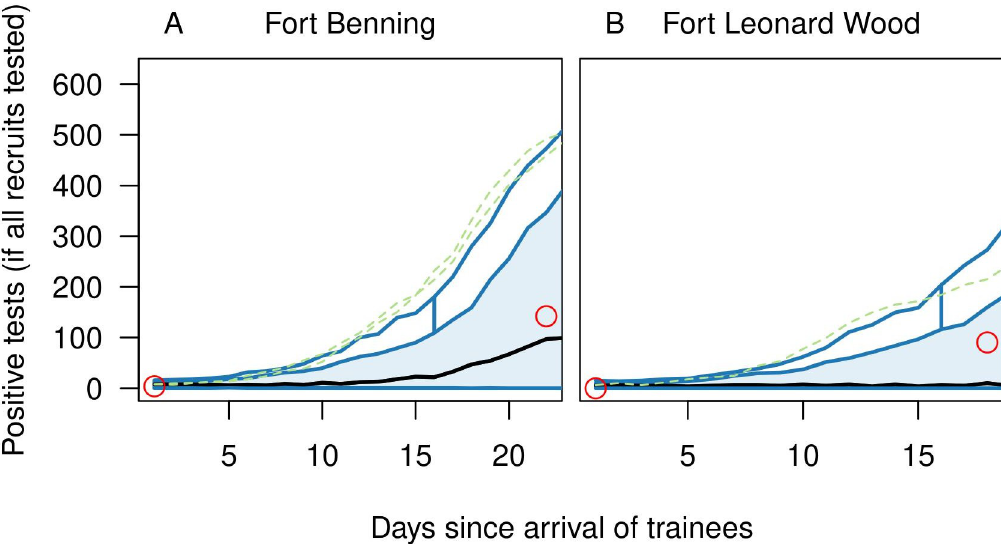
Fig 2. Model calibration to data from outbreaks in basic training settings. Functional boxplots show model predictions from 1,000 replicate simulations for Fort Benning (left) and Fort Leonard Wood (right) based on median parameter values calibrated to data from each (red circles). The functional boxplot shows the median estimate (black line), 50% central region (25–75%) (blue band), 1.5 times the central region (blue lines), and outliers defined as lines outside of 1.5 times the central region (dashed green lines). These results demonstrate agreement between the data and the central tendency of the model but also highlight the degree of stochasticity in the model’s behavior.